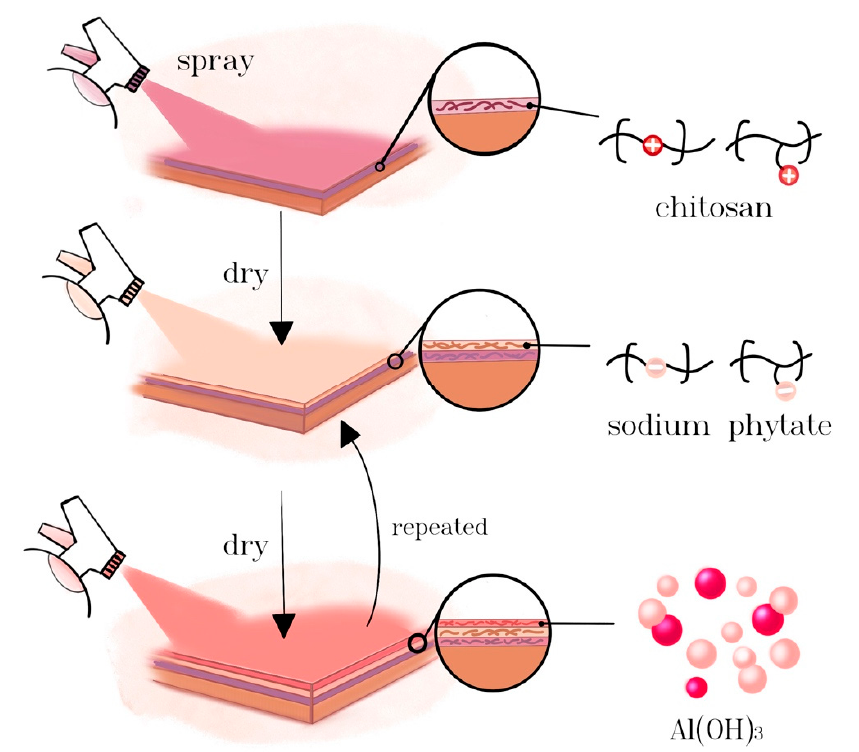
Figure 1. Scheme of fabricating chitosan/sodium phytate/Al(OH) 3 coatings on a wood surface by spray-assisted layer-by-layer self-assembly.